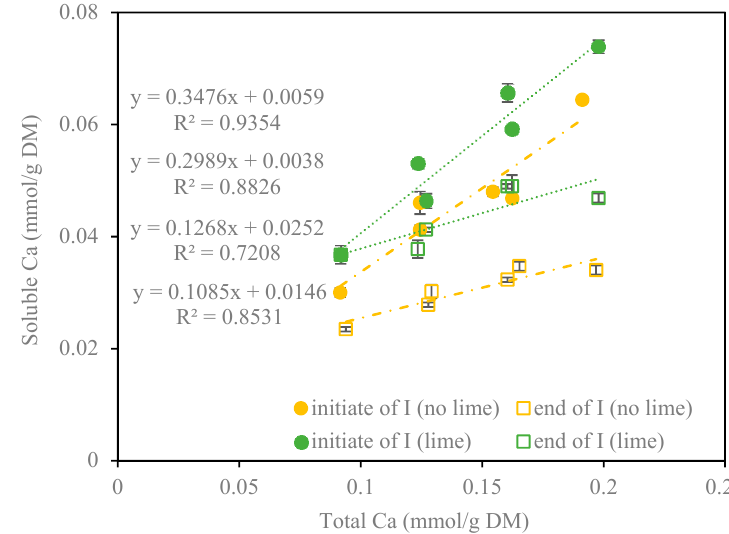
Figure 4. Relationship of soluble calcium versus total calcium per gram dry matter of snacks with or without lime juice addition at the beginning and at the end of intestinal digestion.